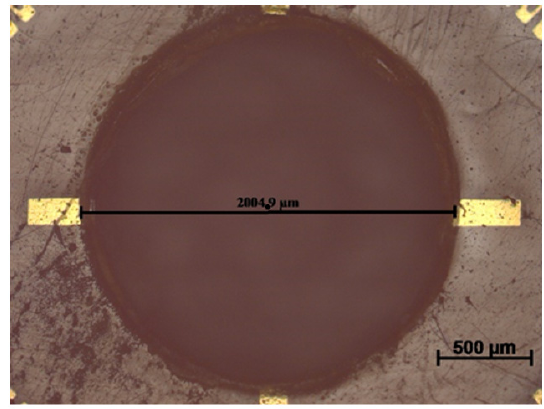
Figure 9. Top view of the drilled hole in the GFRP sample.